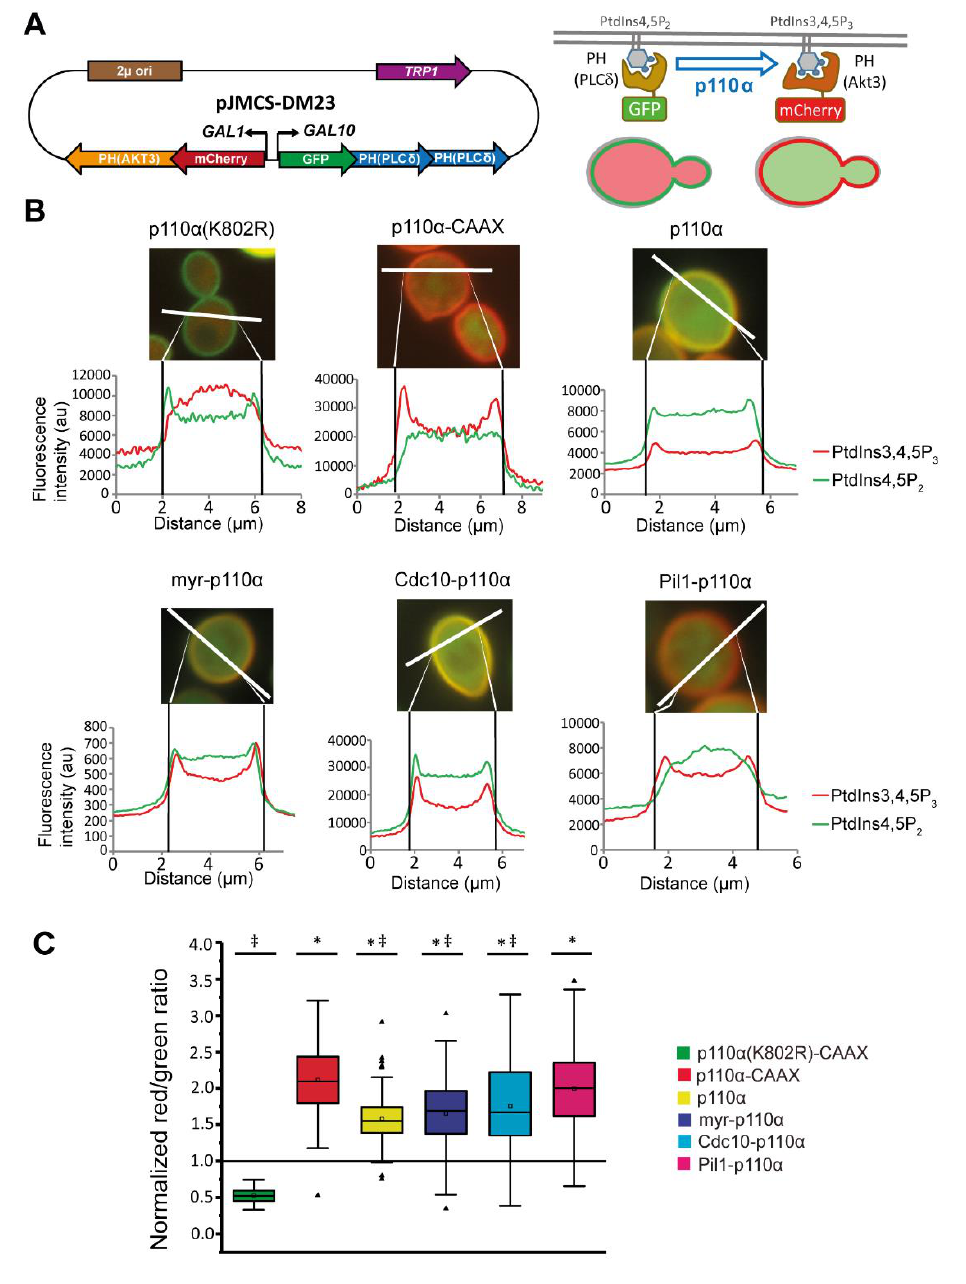
FIGURE 3: Dual Reporter for the Activity of PI3K (DRAPIK) strategy: a double marker to measure PtdIns4,5P 2 and PtdIns3,4,5P 3 at single- cell level. (A) Sketch of plasmid pJMCS-DM23, showing its main elements (left) and rationale and experimental design for the double marker analyses (right). Both fluorescent reporters are expressed simultaneously; yeast PM is rich in PtdIns4,5P 2 and lacks PtdIns3,4,5P 3 , leading to recruitment of the green reporter to the PM whereas the red reporter remains cytoplasmic. Expression of PI3K should revert this situation proportionally to its enzymatic activity, the efficiency of its recruitment to the PM, and local substrate availability. (B) Representative fluo- rescence microscopy merged (red and green channels) images of YPH499 cells co-transformed with pJMCS-DM23 and expression plasmids for p110α(K802R), p110α-CAAX, p110α, myr-p110α, Cdc10-p110α and Pil1-p110α PI3K versions. Below, densitometric histograms showing the red (PtdIns3,4,5P 3 ) and green (PtdIns4,5P 2 ) fluorescence intensity in arbitrary units (au) along a transversal section of the cell, depicted above in white color, whose distance is represented in µm in abscissae. (C) Graph representing normalized red:green ratio [(PtdIns3,4,5P 3 ) vs (PtdIns4,5P 2 )] for a population of individually monitored randomly chosen cells (n=90 per experiment) adjusted to a normal distribution. Cells co-express the same plasmids than in (B) . The symbols *, ‡ and # express statistical significance when compared to p110α-KD, p110α- CAAX or Pil1-p110α, respectively (Bonferroni p-value < 0.01 for two symbols and < 0.001 for three). The symbols ▫ and ― represent the average and median values of the population; the colored boxes cluster the data between 25% and 75% of the population; the bars with a capped end (I) cluster the data between 5% and 95% of the population; the outlier data are represented by the symbol